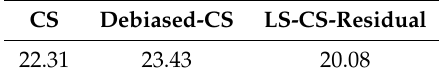
Table 1. Time taken (in minutes) by the three